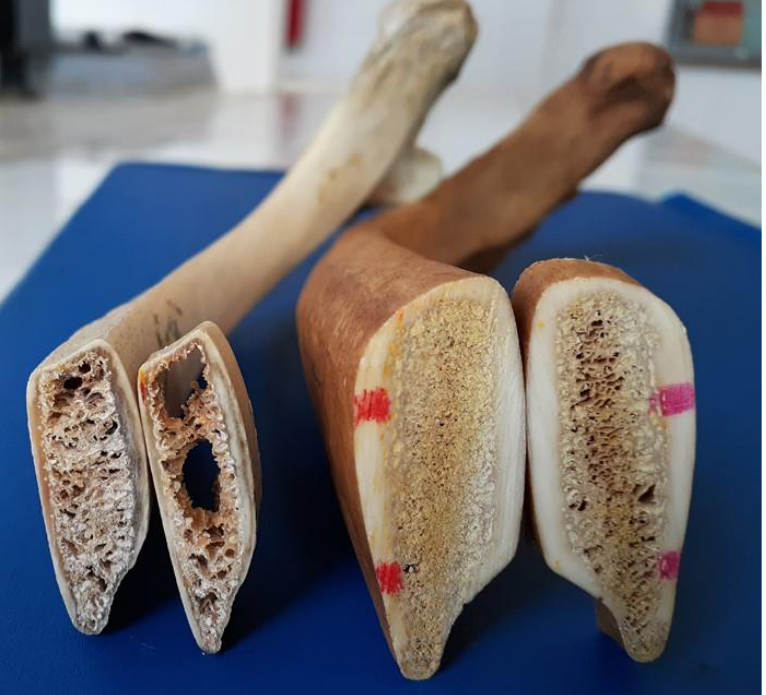
Figure 10. A twelfth rib from an adult bovine clinically deficient (left) and one from an animal not deficient (right) in P [11]. Note that the cortical thickness of the cranial border of the lateral side of the rib (upper red mark) is thicker than the caudal border (lower red mark). In summary, the pro- fessional should always measure the CT on the lateral side of the rib and on its cranial